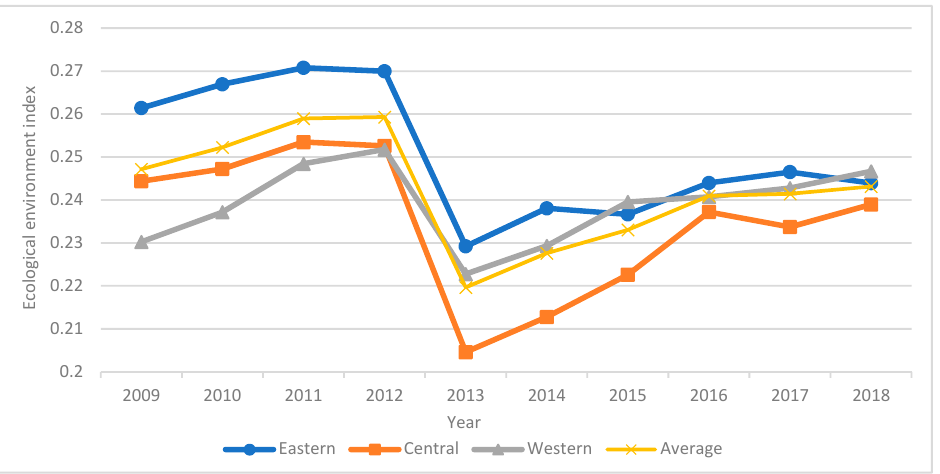
Figure 4. Changes in the ecological environment index in the eastern, central, and western regions over time.